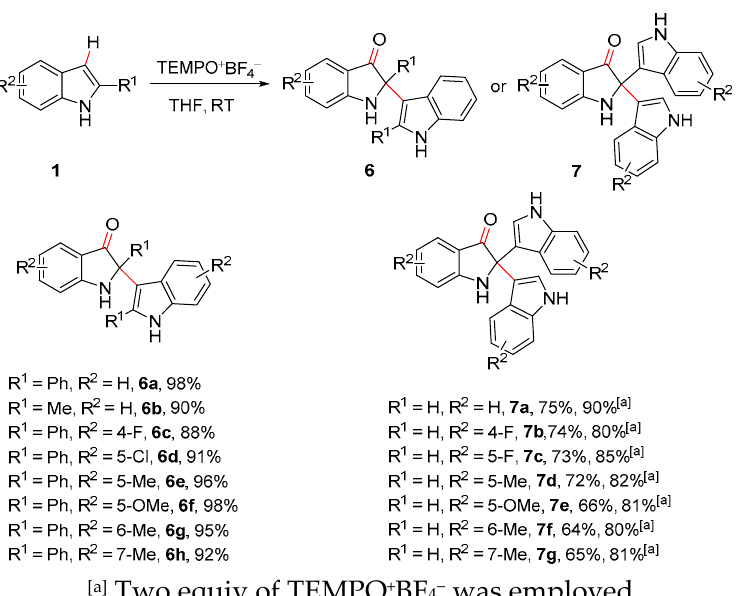
Figure 5. Oxidative dimerization and trimerization of indoles.